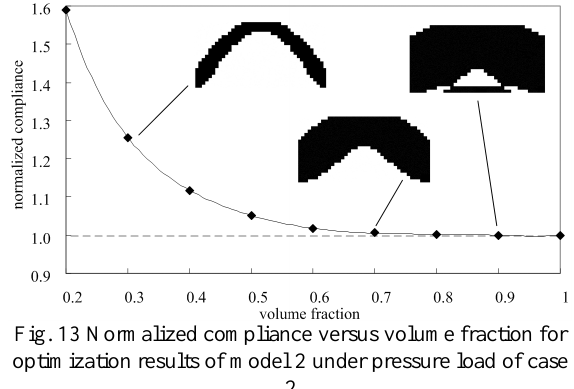
Fig. 13 Normalized compliance versus volume fraction for optimization results of model 2 under pressure load of case